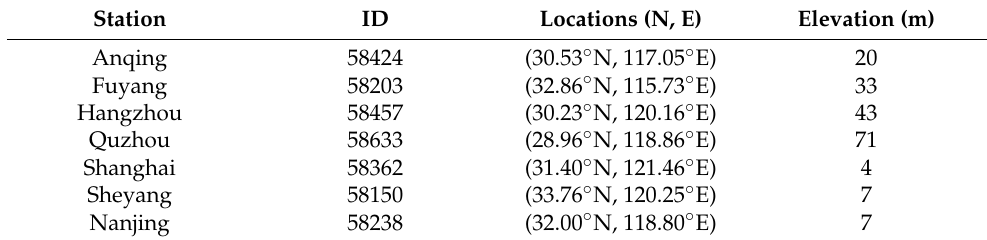
Table 1. Location information of 7 radiosondes in the Yangtze River Delta region.